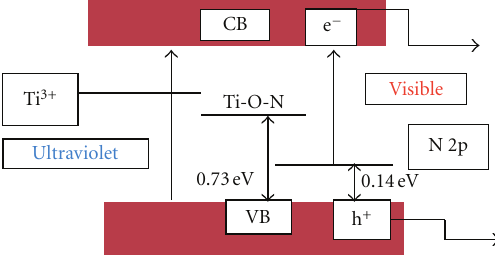
Figure 1: Schematic energy level diagram for nitrogen substituted TiO 2 [Bare semiconductor absorbs UV radiation while the localized energy levels of nitrogen above valence band facilitate the visible light